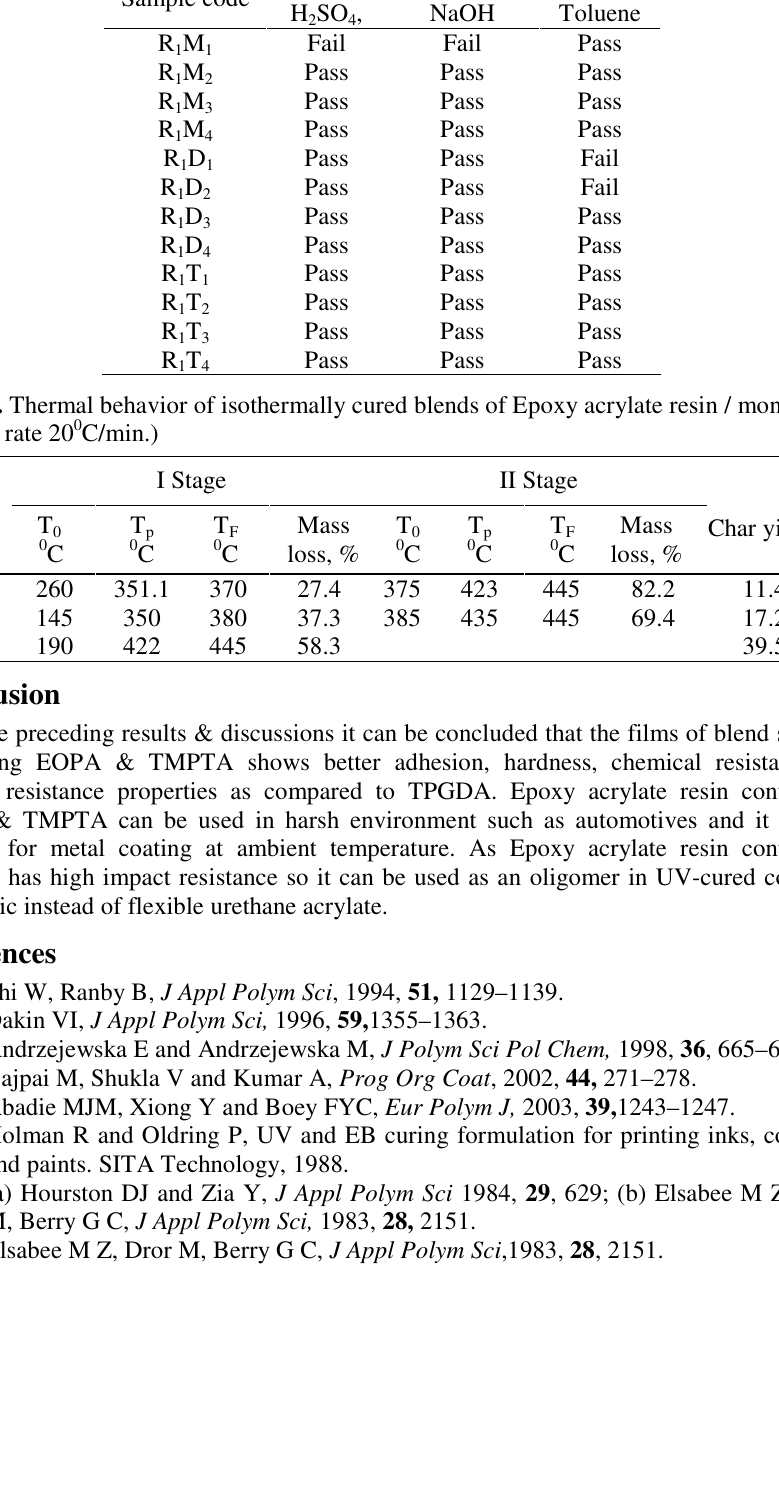
Table 3. The comparative acid, alkali & solvent resistance of cured film blends Chemical properties of paint films Sample code